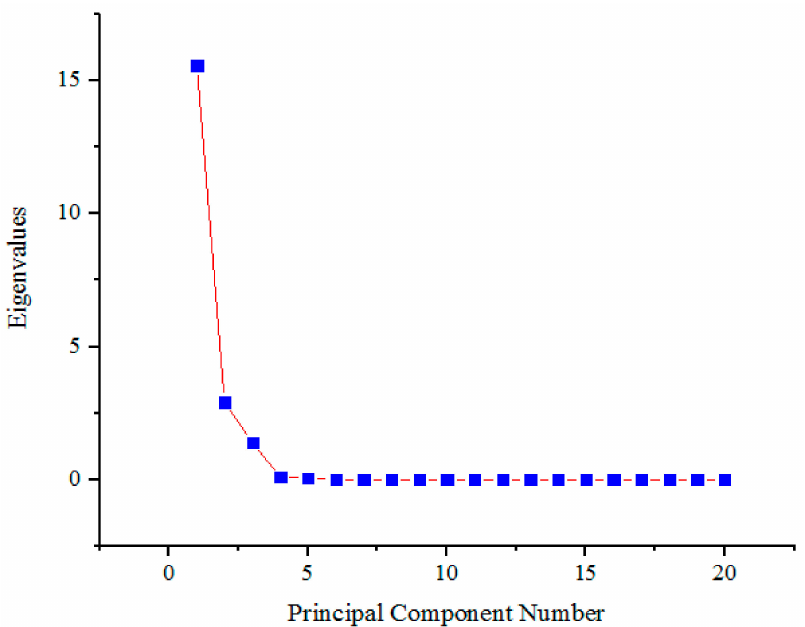
Figure 6. Scree plot of principal component analyses (PCA) between respective eigenvalues % and components